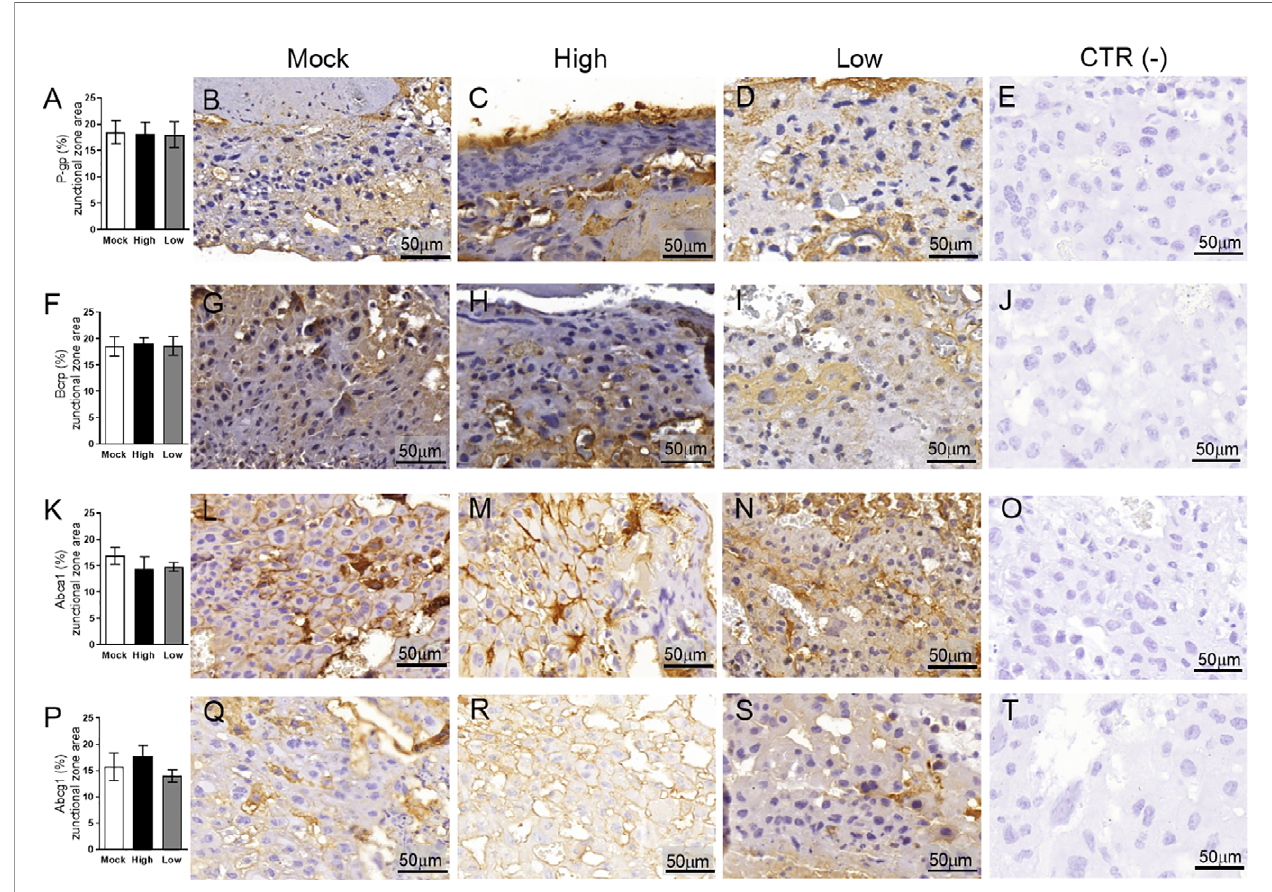
FIGURE 10 | ZIKV infection did not impact P-gp, Bcrp, Abca1 or Abcg1 protein expression in the placental Jz of infected mice in the ICompetent groups. A total of 180 digital images (40X) randomly captured from the whole junctional zone (Jz) of each placenta per dam were evaluated. Immunolabeling in each digital image was quanti fi ed by calculating the percentage area of the total stained junctional zone tissue after exclusion of the total negative space. (A) Quanti fi cation and (B – D) representative photomicrographs of P-gp staining in the Jz of ICompetent (n=6 placentae from 6 independent dams/group) placenta. (F) Quanti fi cation and (G – I) representative photomicrographs of Bcrp staining in the Jz of ICompetent (n=6 placentae from 6 independent dams/group) placenta. (K) Quanti fi cation and (L – N) representative photomicrographs of Abca1 staining in the Jz of ICompetent (n=6 placentae from 6 independent dams/group) placenta. (P) Quanti fi cation and (Q – S) representative photomicrographs of Abcg1 staining in the Jz of ICompetent (n=6 placentae from 6 independent dams/group) placenta. (E, J, O, T) Negative controls. One-way ANOVA followed by Tukey ’ s post-test. The values are expressed as the mean ± SEM. Images were captured at 40X. Scale bar = 50